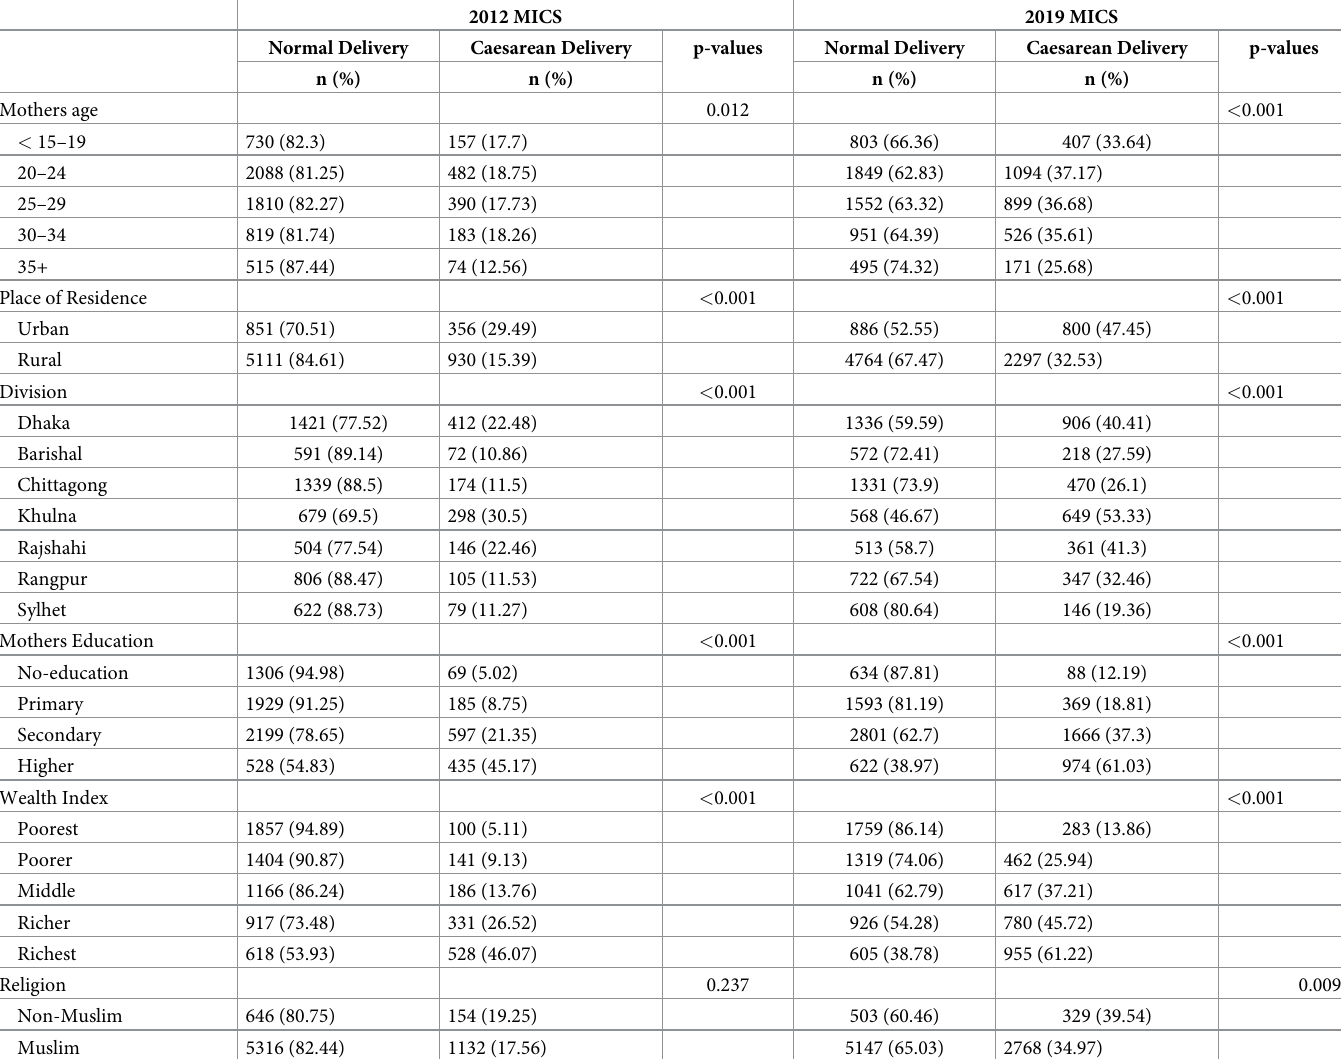
Table 2. Sample characteristics of mother and children by delivery status, MICS 2012 and